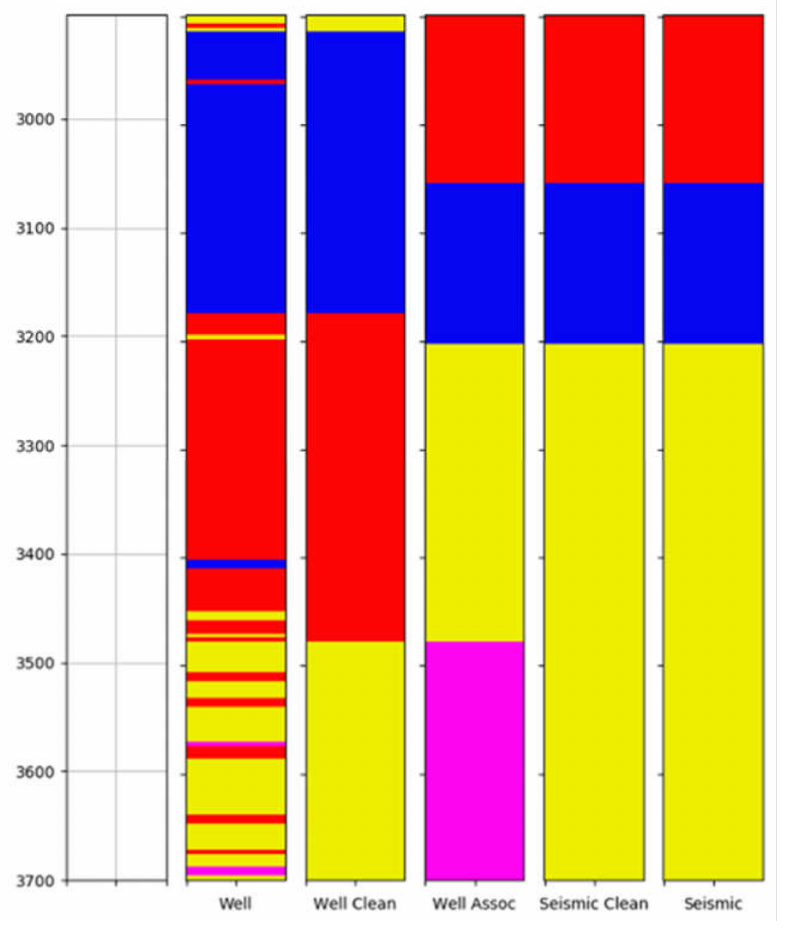
Figure 22. Association